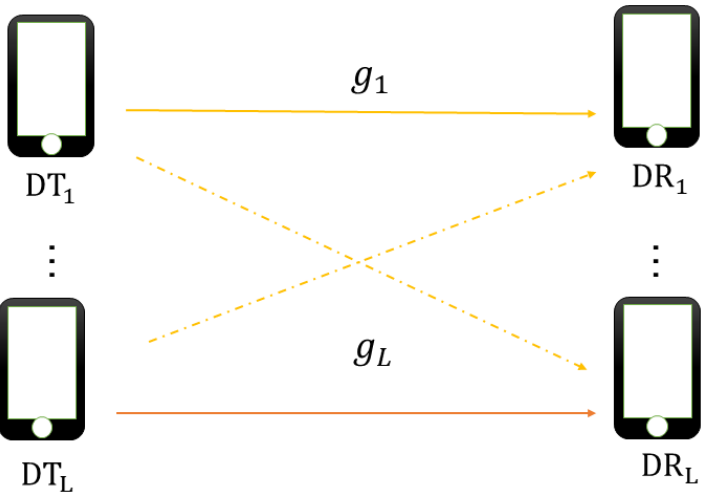
Figure 2. System model for the NOMA-based D2D communication system with L D2D